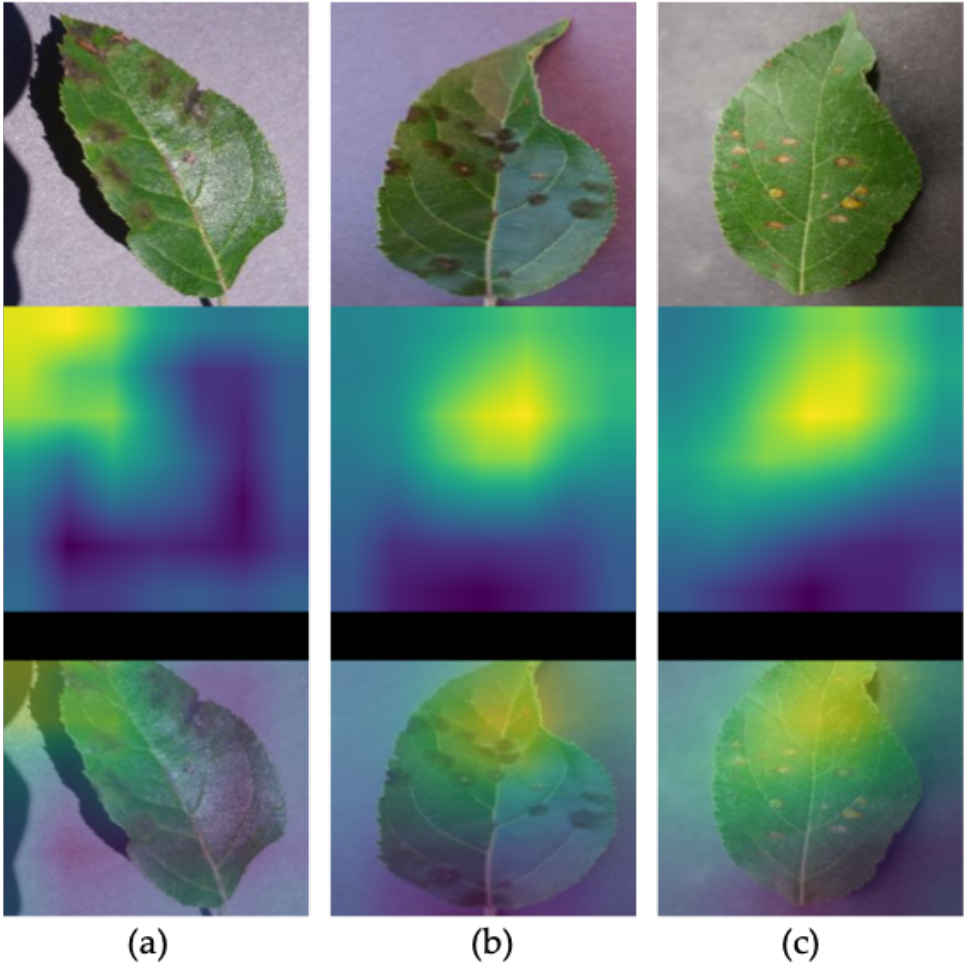
Figure 8. Examples of images that were classified correctly belonging to Plant Village dataset. In each photo, from left to right, we see the original image ( a ), the generated heatmaps of the last convolution layer ( b ), and the overlap of the two images ( c